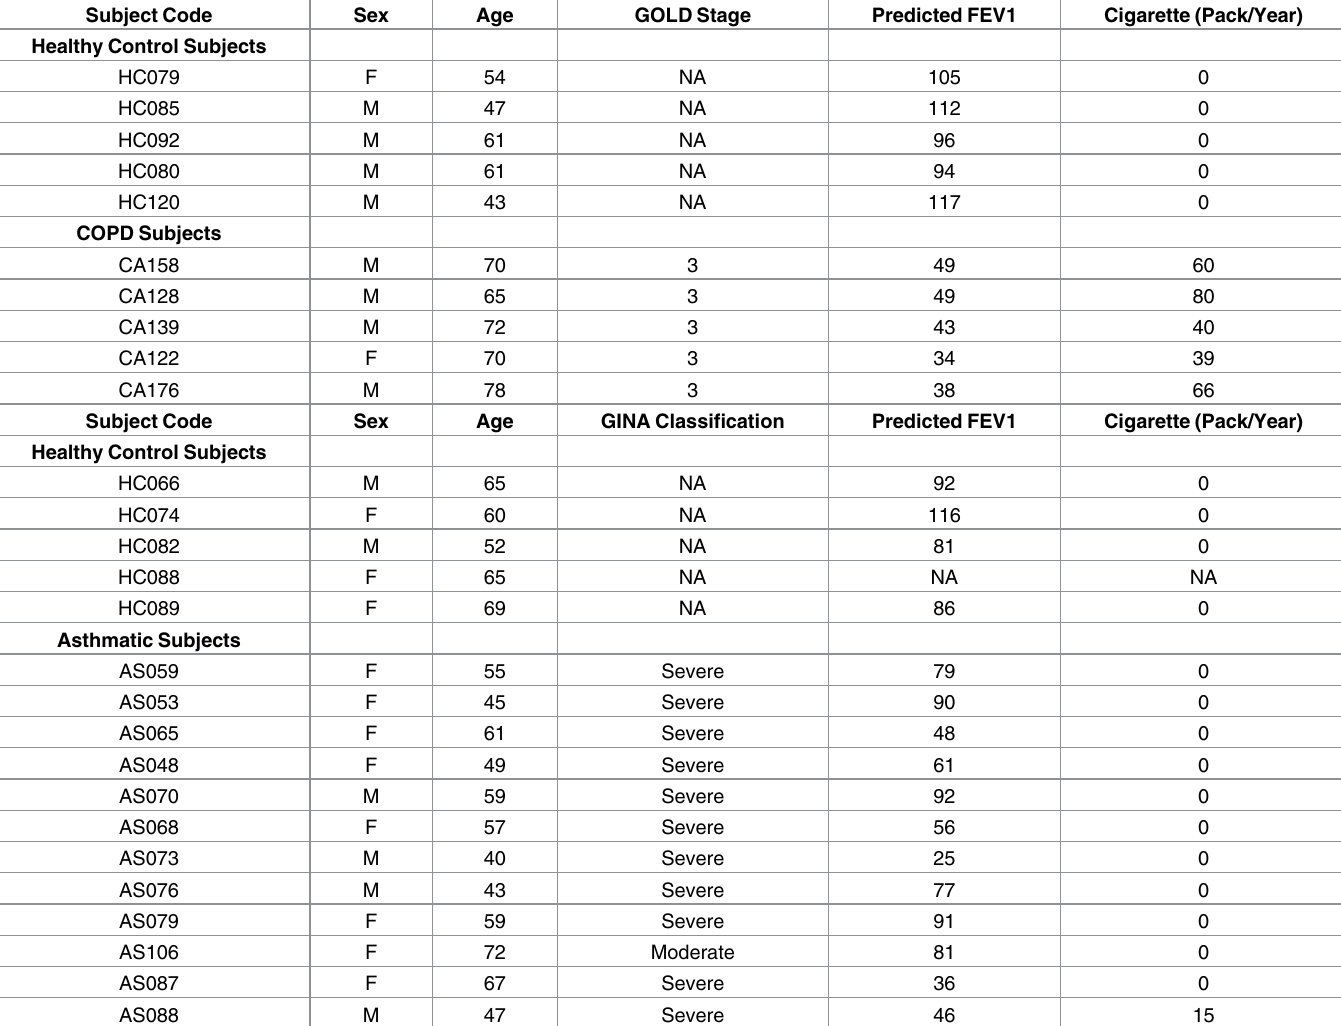
Table 1. Clinical subject